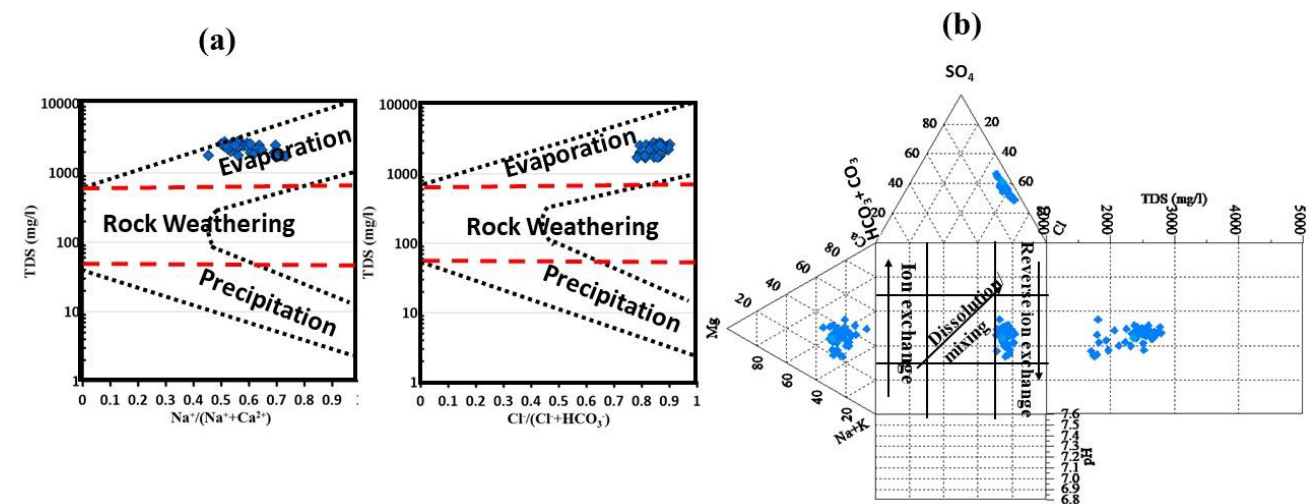
Figure 6. Graphical representation of the main geochemical mechanism that controls the chemistry of the water through integration of the physicochemical parameters: ( a ) Gibbs plot; ( b ) Durov dia- gram.